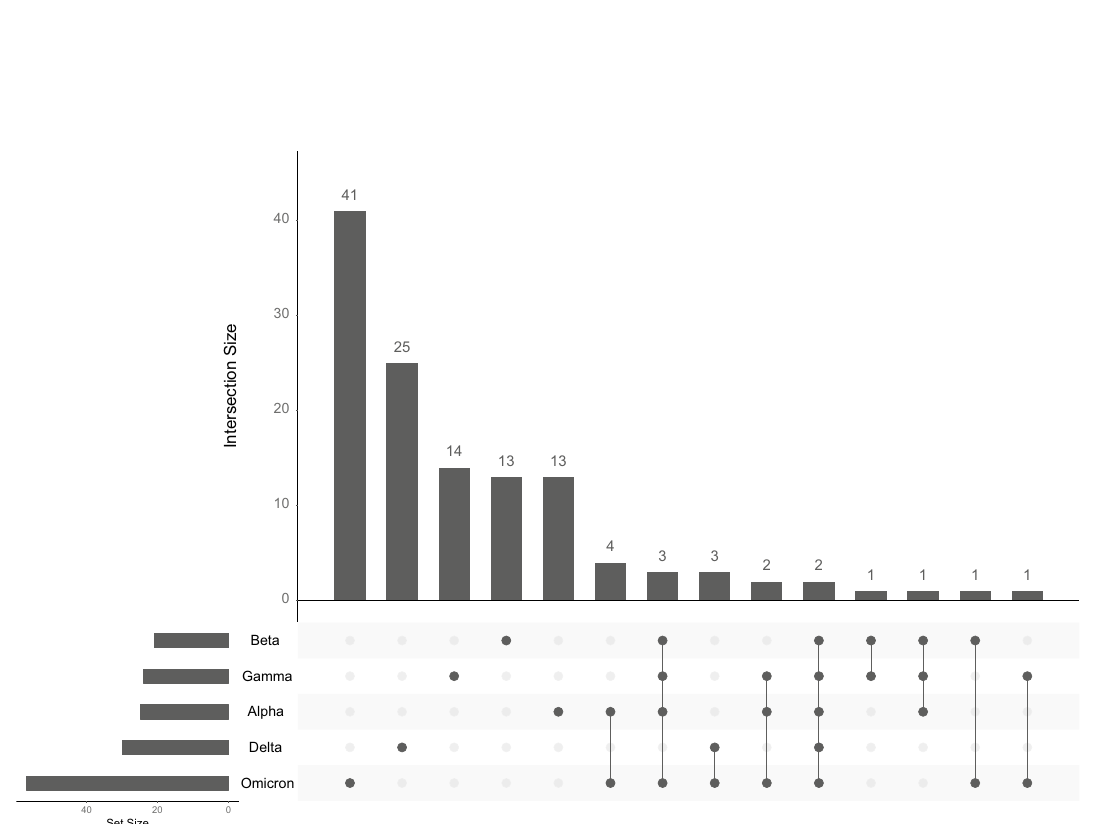
Figure 3. Comparison of the mutation profile of the SARS-CoV-2 VOCs. A few mutations are shared among the genotypes while most of them are exclusive to each genome, making it possible to map and track genome subsequences to identify the concomitant presence of